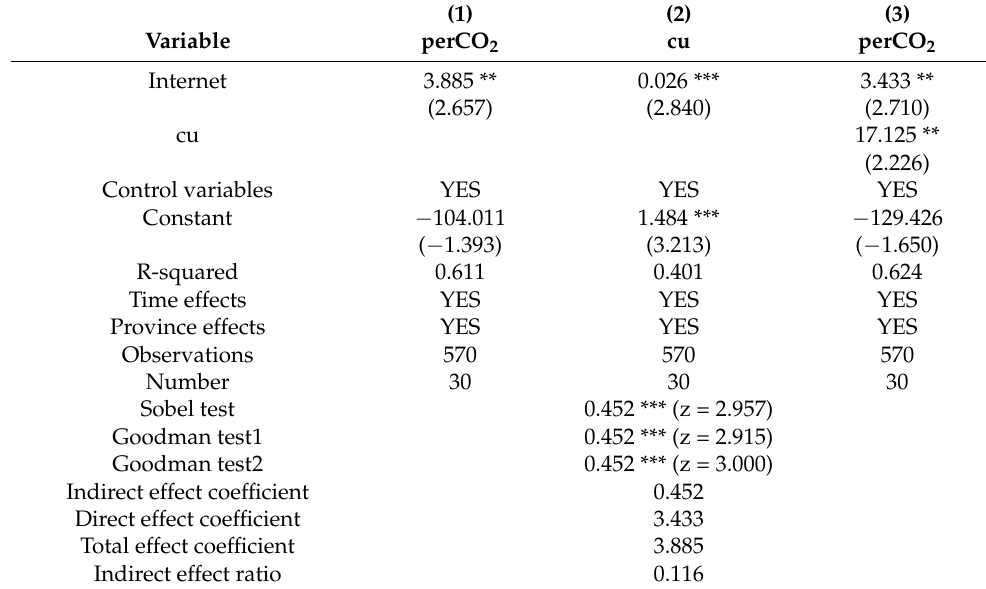
Table 2. Regression